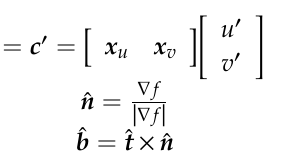
Figure 5. Geodesics on a wrapping surface. From the di ff erential geometry, the tangent, normal and binormal unit vectors, ˆ t , ˆ n and ˆ b , respectively, are given in